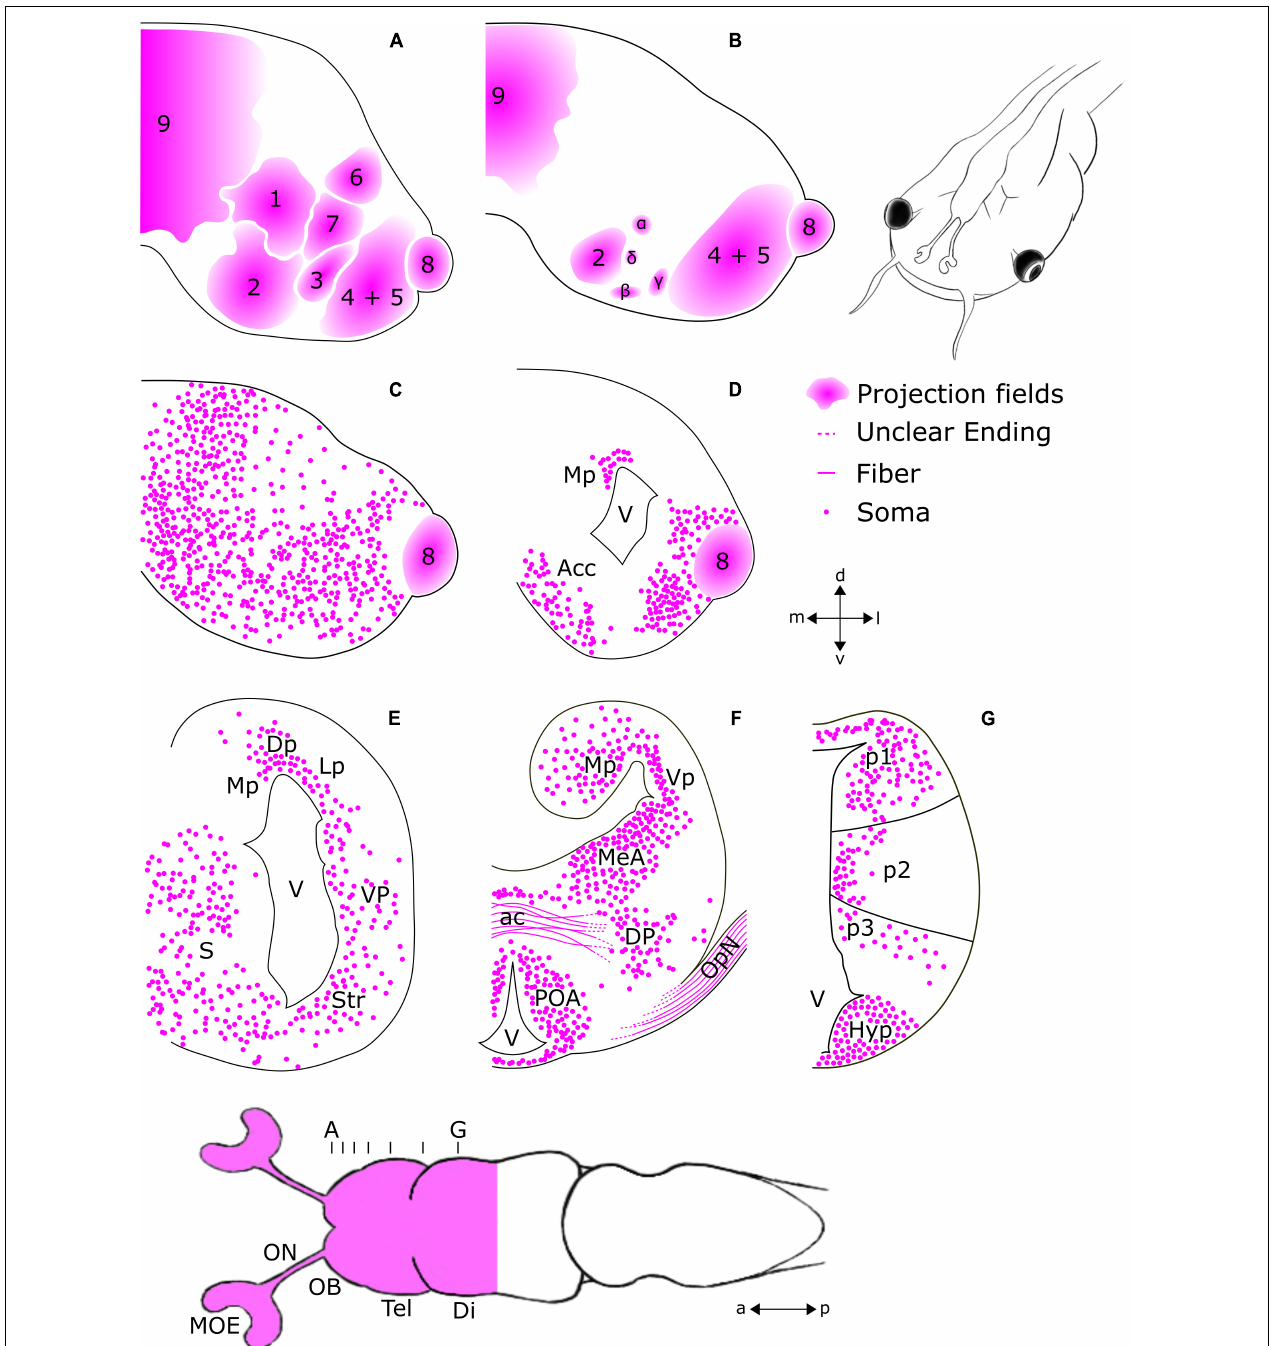
FIGURE 2 | Schematic overview of regions featuring tubb2b -dependent fluorescence in the forebrain of premetamorphic Xenopus laevis . Ventral view of the larval forebrain and transverse sections of the olfactory bulb (OB; A–C ), telencephalon (Tel; A–F ), diencephalon (Di), and hypothalamus (G) . The position and density of the cells shown for each region are presented based on observation and not via quantitative analysis. (A,B) tubb2b -dependent fluorescence is present in projection fields of axons arriving from the olfactory epithelium (1–9 + α , β , γ , δ ; Gaudin and Gascuel, 2005). (C,D) tubb2b -dependent fluorescence in cells of the mitral cell layer of the main and accessory olfactory bulbs, the nucleus accumbens (Acc), and pallium. (E) tubb2b -dependent fluorescence in the medial pallium (Mp), lateral pallium (Lp), dorsal pallium (Dp), ventral pallium (Vp), striatum (Str), and septum (S). (F) tubb2b -dependent fluorescence in the anterior commissure (ac), medial amygdala (MeA), optic nerve (OpN), dorsal pallidum (DP), and preoptic area (POA). (G) tubb2b -dependent fluorescence in prosomeres 1–3 (p1–3). Hyp, Hypothalamus; lfb, lateral forebrain bundle; V, ventricle; MOE, main olfactory epithelium; ON, olfactory nerve; a, anterior; p, posterior; d, dorsal; v, ventral; l, lateral; m,